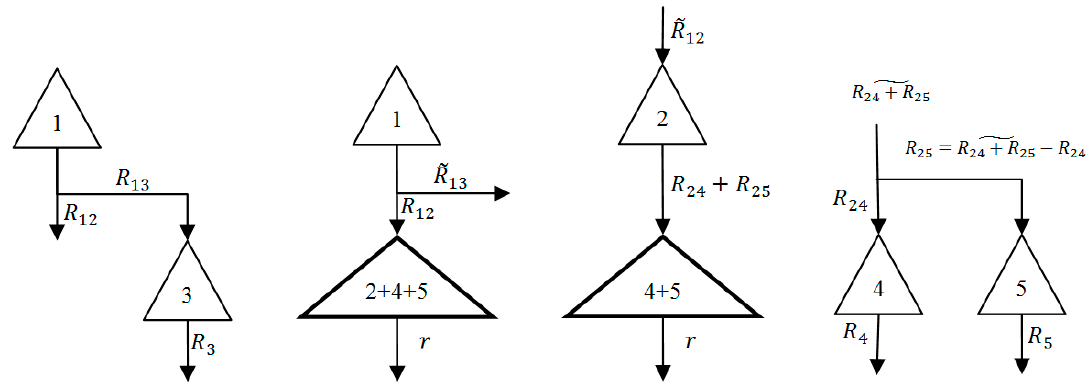
Figure 6. The sub-problems of PAP using the multilevel approximation-dynamic programming (MAM-DP) method [28].